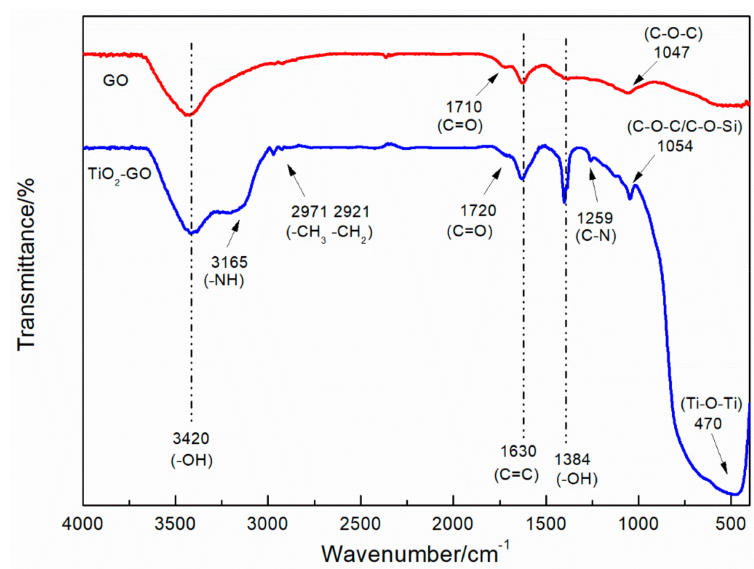
Figure 2. FT-IR spectra of TiO 2 –GO and GO.